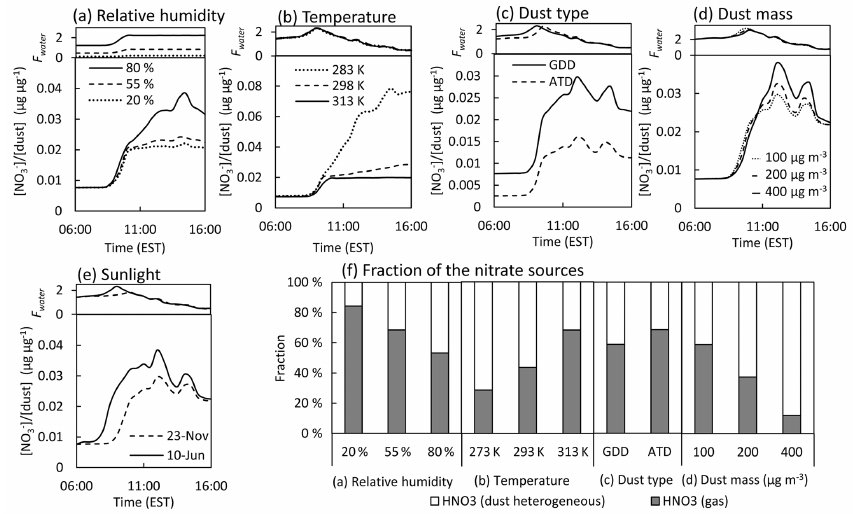
Figure 5. Sensitivity of the model nitrate prediction to the (a) relative humidity at 20%, 55%, and 80%; (b) temperature at 273, 293, and 313K; (c) ATD vs. GDD particles; (d) concentration of GDD at 100, 200, and 400µgm − 3 ; and (e) sunlight profile on 23 November 2017 vs. 10 June 2017. The fraction of the HNO 3 sources formed from the gas-phase reaction and dust-phase heterogeneous reaction to the total HNO 3 is shown in (f) . The simulation was conducted with 100µgm − 3 of initial GDD particles, 40ppb of initial NO x (NO : NO 2 = 1 : 1), 2ppb of initial O 3 , and 10ppb of isoprene under ambient environmental conditions on 23 November 2017. The simulation was performed without considering particle